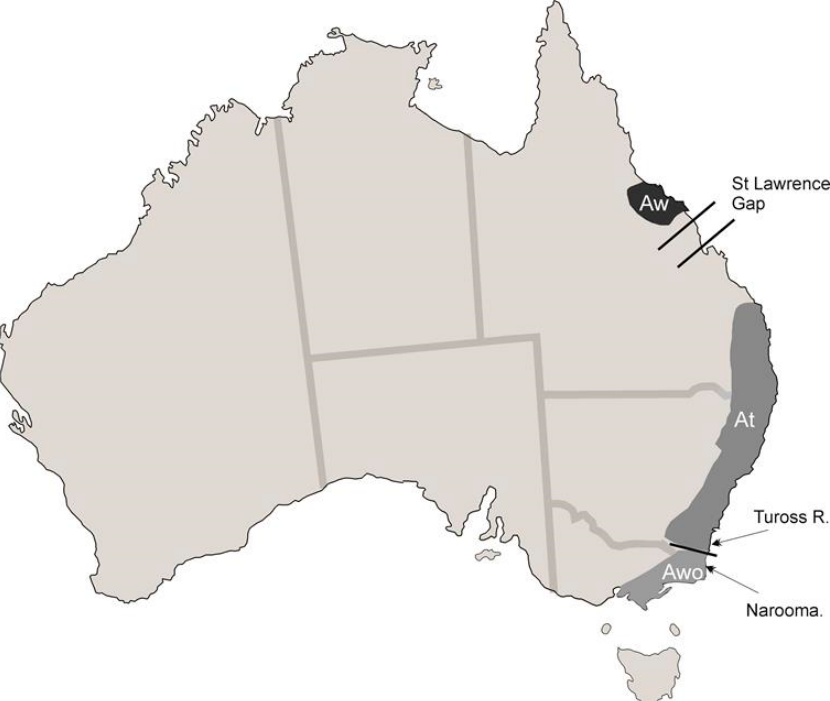
Figure 7. Distribution of species of Acroseius : Aw— A. weiri , At— A. tuberculatus , Awo— A. womersleyi against biogeographical boundaries of Australia (according to Błoszyk et al. 2013 [11], slightly changed).